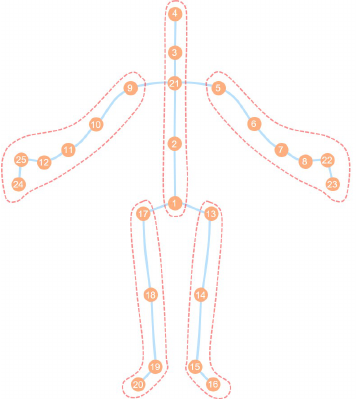
Figure 3. Human body part division